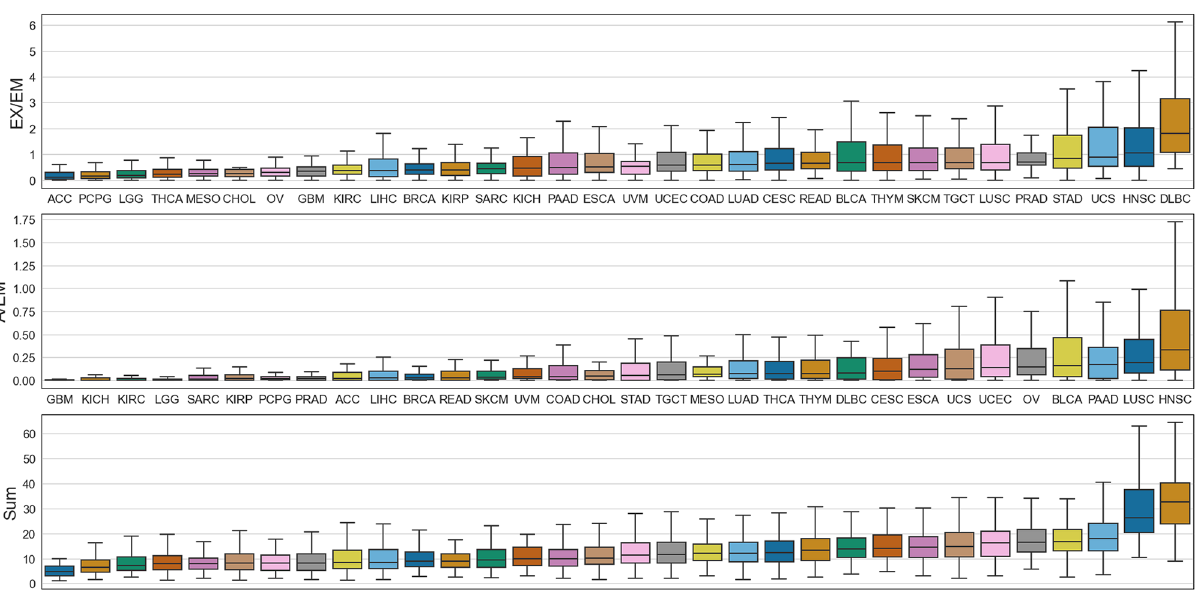
Figure 5. T Cell Subtype Profiling of many cancers. Box and whisker plots show the inter- and intra-tumor variance of various TCGA projects for: the effector memory-normalized exhausted levels (EX/EM), and the effector memory-normalized activated levels (A/EM), and the sum total infiltrate (Sum). Outliers are omitted for visual